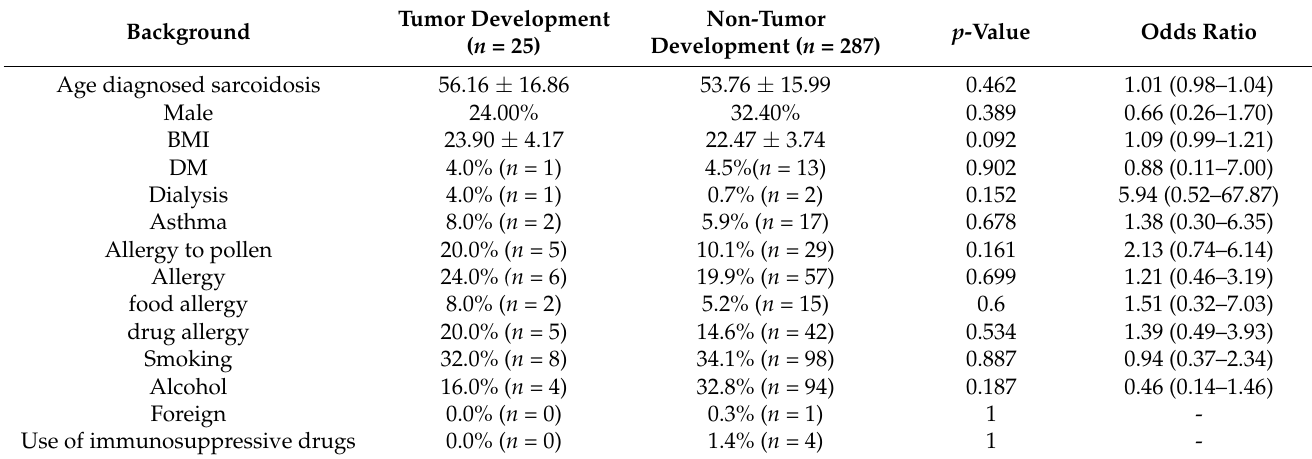
Table 2. A statistical comparison of the background of patients between the tumor development group and the non-tumor development group.